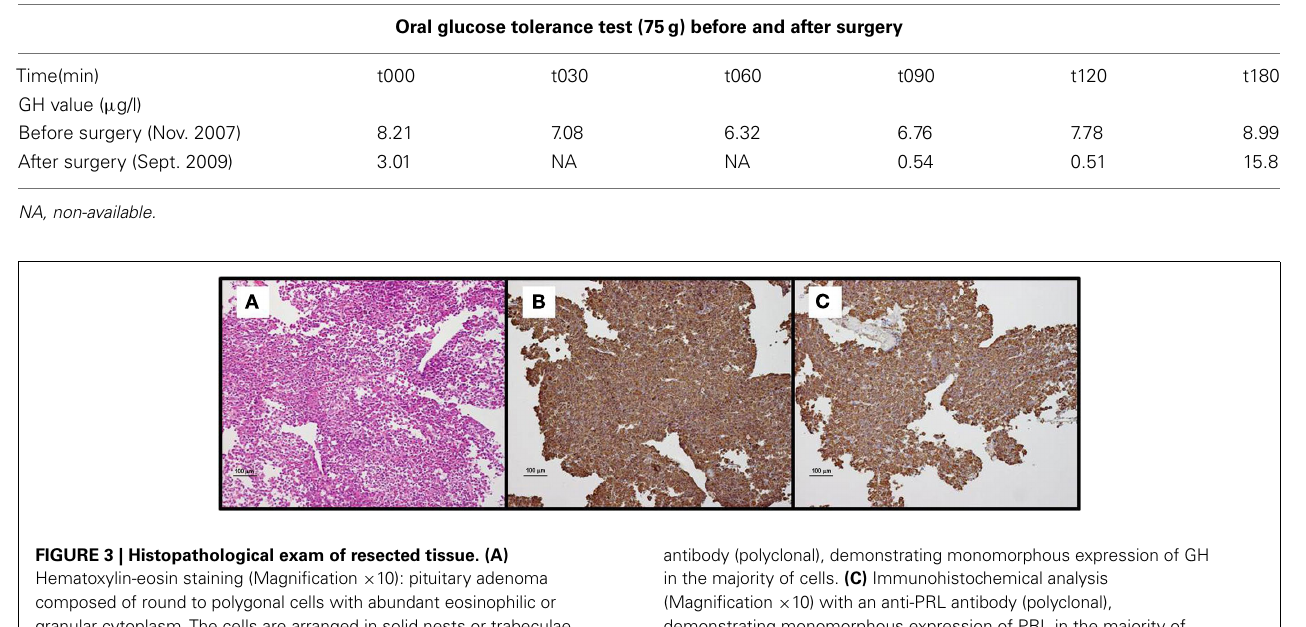
Table 1 | Results of the oral glucose tolerance tests ( = oGTT) performed before and after successful trans-sphenoidal surgery, demonstrating the lack of inhibition of GH before surgery, and the inhibition of GH levels to a nadir of 0.51ng/mL followed by physiological rebound at 180min after surgery.